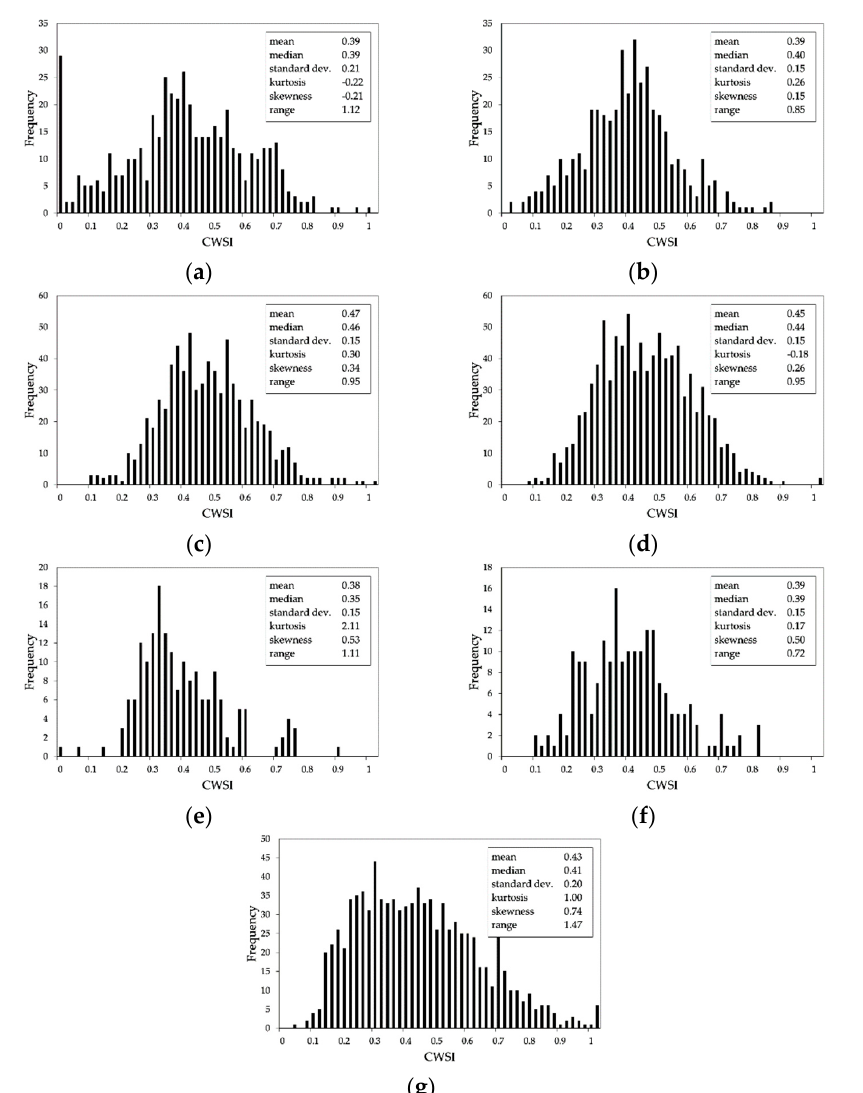
Figure 13. Distribution of the CWSI values within each SSMZ shown in Figure 12a: ( a ) SSMZ 1; ( b ) SSMZ 2; ( c ) SSMZ 3; ( d ) SSMZ 4; ( e ) SSMZ A; ( f ) SSMZ B; ( g ) SSMZ C.